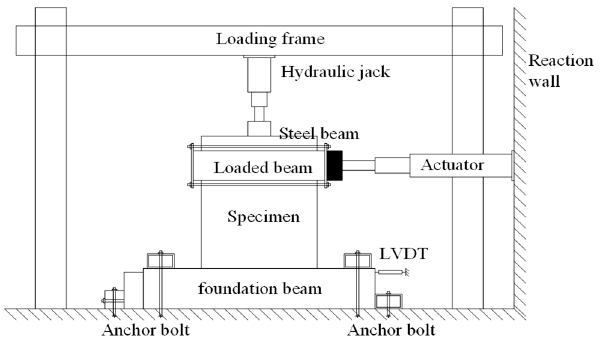
Figure 4. Loading device of the test.